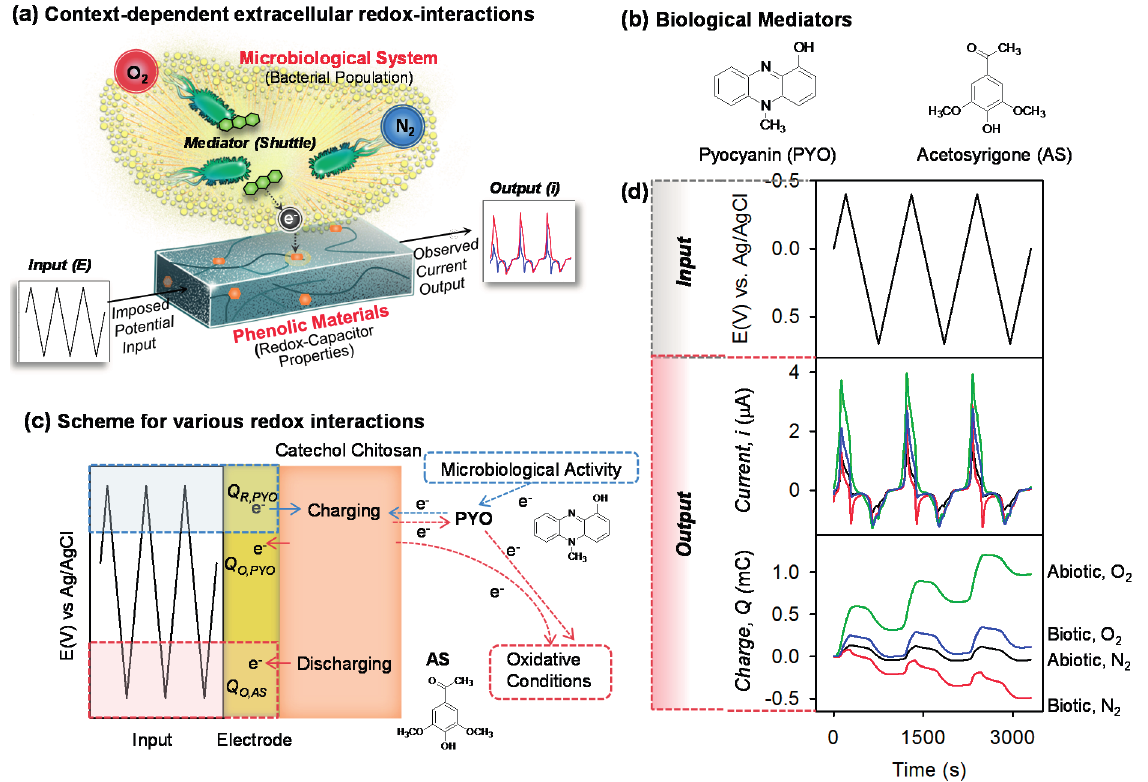
Figure 17. Acquiring global redox-information using the catechol-chitosan redox-capacitor. ( a ) Schematic illustrating how diffusible mediators transfer electrons between biological milieu and the redox-capacitor while cyclic electrical inputs and outputs read this information; ( b ) Biological mediators used for electron exchange; ( c ) redox-interactions of pyocyanin; ( d ) Input/output curves generated from four conditions. Reproduced with permission from [249], published by American Chemical Society,